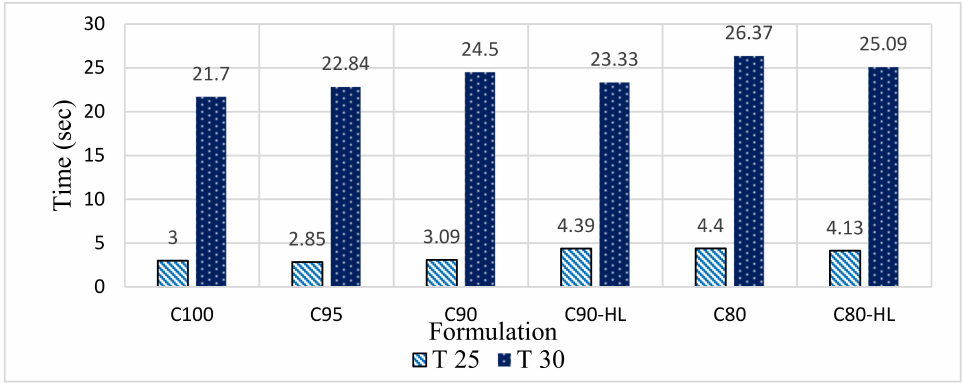
Figure 8. Effect of waste burnt brick powder on T25 cm (paste yield strength parameter) and T30 cm (paste viscosity parameter) of self-compacting paste formulations flow.